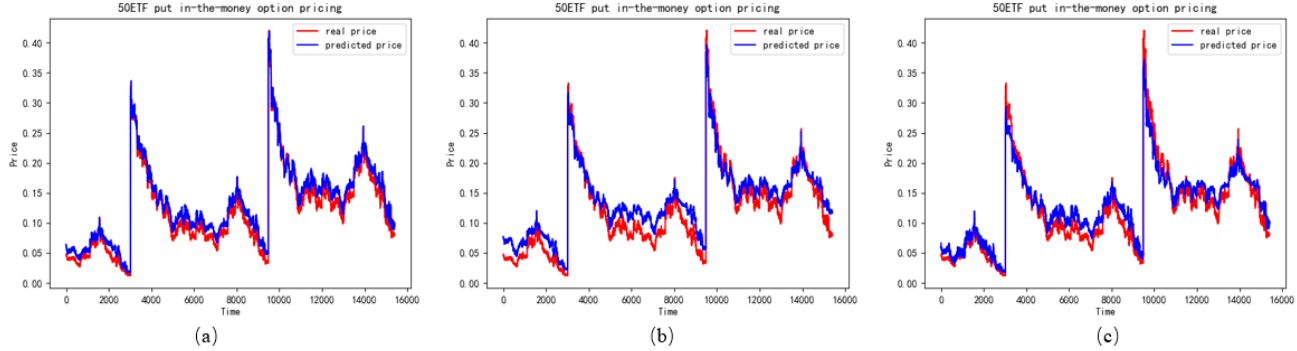
Figure 9. The performance of OTM call options in different features ( a ) represents the LSTM with realized skewness, ( b ) represents the LSTM without realized skewness, ( c ) represents the LSTM with realized skewness and realized kurtosis.